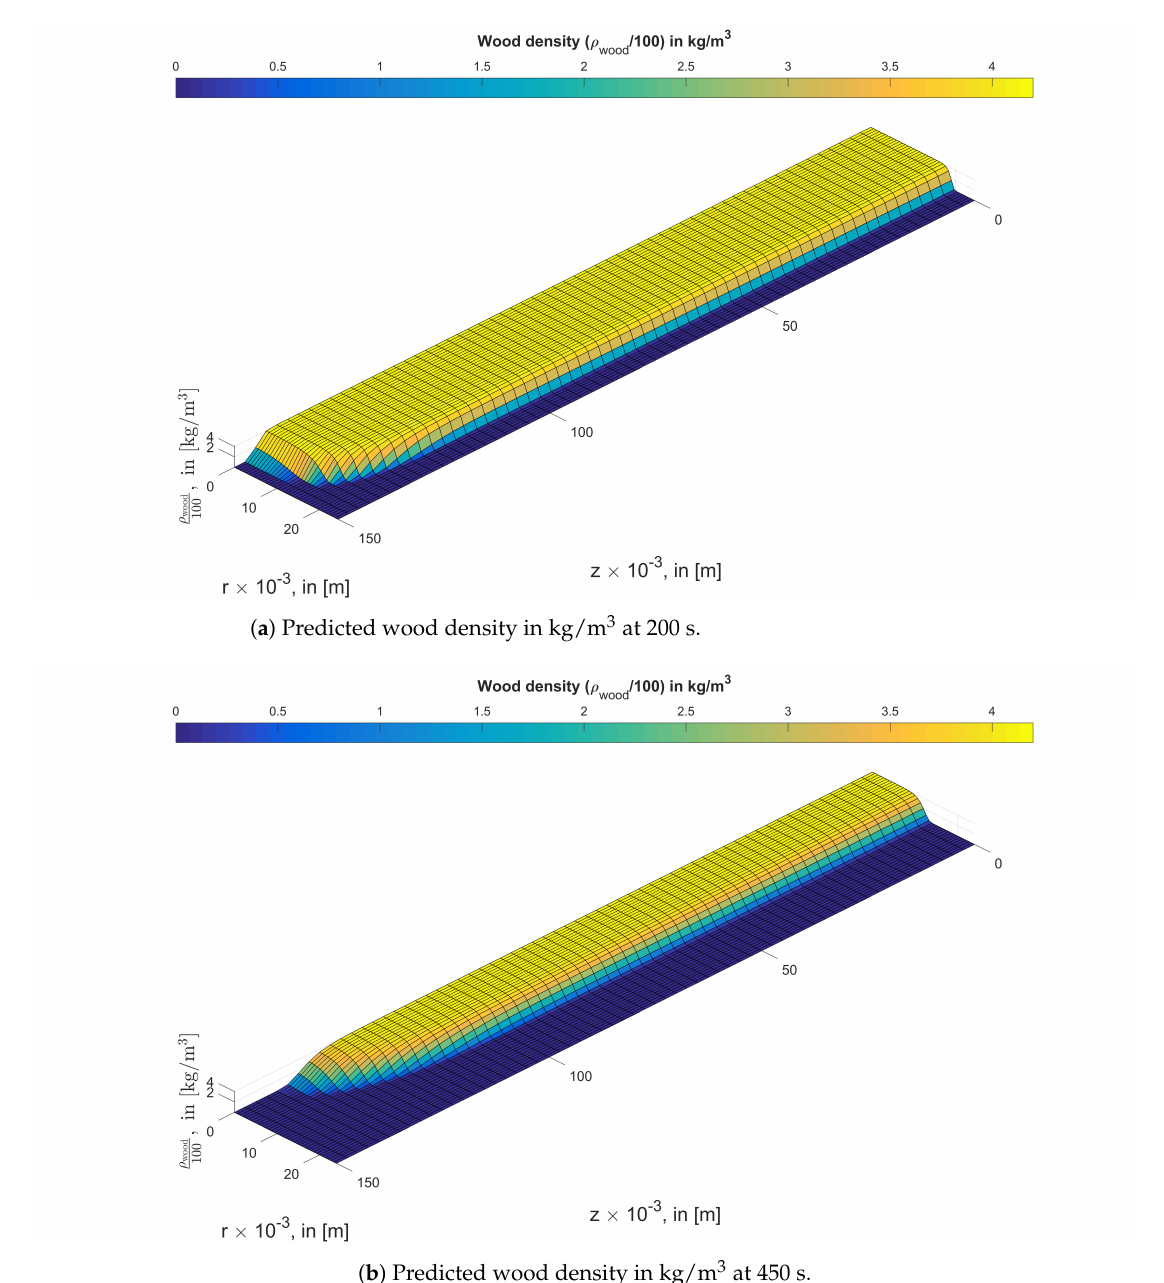
Figure 4. Wood densities in kg/m 3 at 200 s and 450 s during devolatilization. The top of the wood log is at z = 150 mm, and the lateral shell surface of the wood log is at r = 25 mm. Even though the thermal conductivity is higher in the longitudinal than in the radial direction, the wood is primarily converted by the devolatilization zone moving in the radial direction. This is a result of the ratio between the radial and the longitudinal dimensions of the wood log. The wood log is six times longer ( L ) than its diameter ( D ), which means that the (initial) ratio between the total surface of the devolatilization front moving in the radial ( S R ) and longitudinal ( S L ) directions is given by S R / S L = 12. (Here, the devolatilization front is defined as the surface within the devolatilization zone with the highest primary devolatilization rate.) The result of this S R / S L ratio is that even though the devolatilization front moves faster in the longitudinal than in the radial direction, the fact that